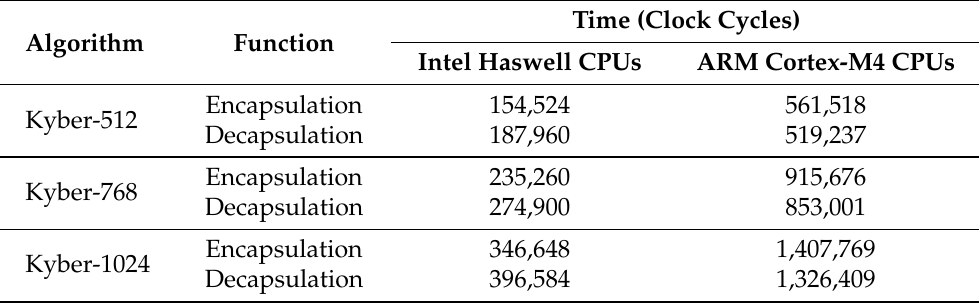
Algorithm 7: CBD η : B 64 η → R q [18].